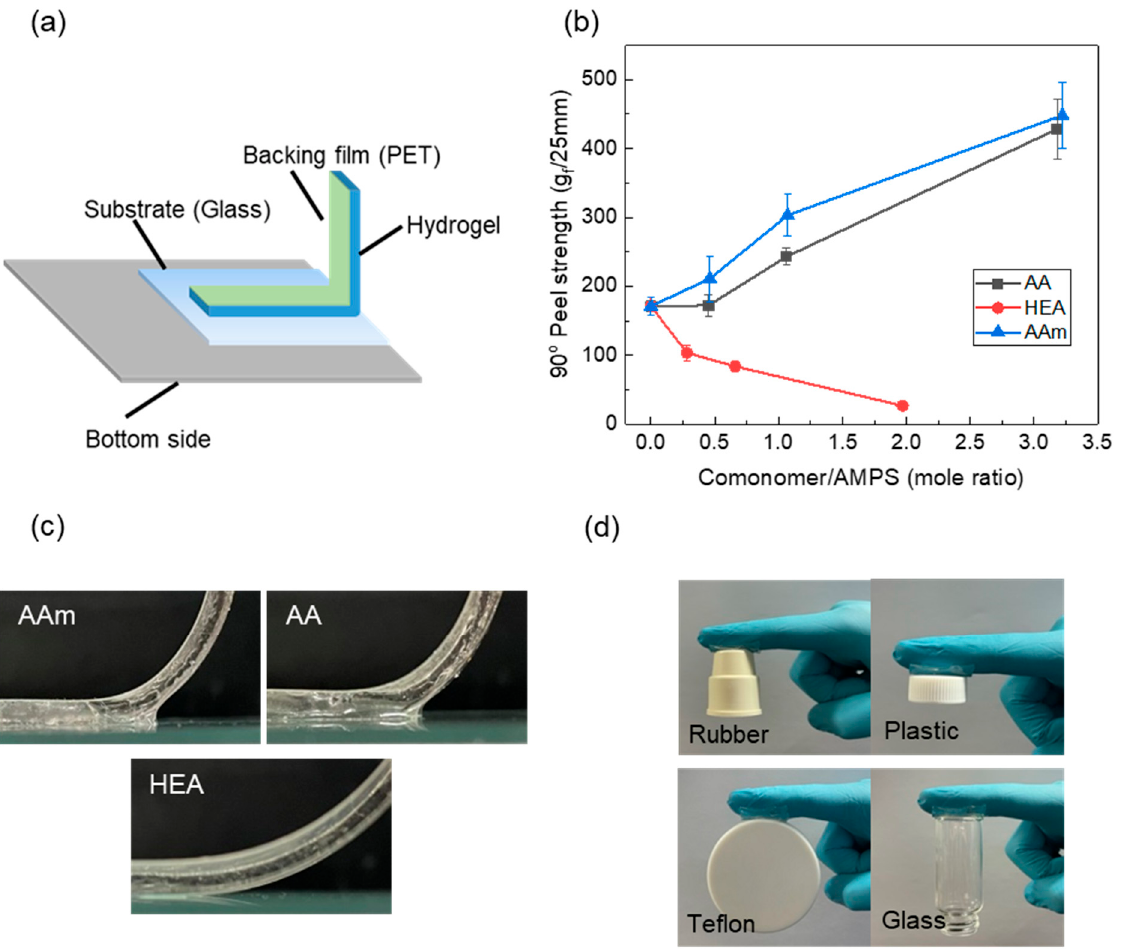
Figure 3. ( a ) Schematic diagram of the 90 ° peel test; ( b ) the 90 ° peel strength of AMPS hydrogels modified with different comonomers; ( c ) photos of the hydrogel–glass interface during peeling test; ( d ) adhesion of the AAm20 hydrogel on different materials.